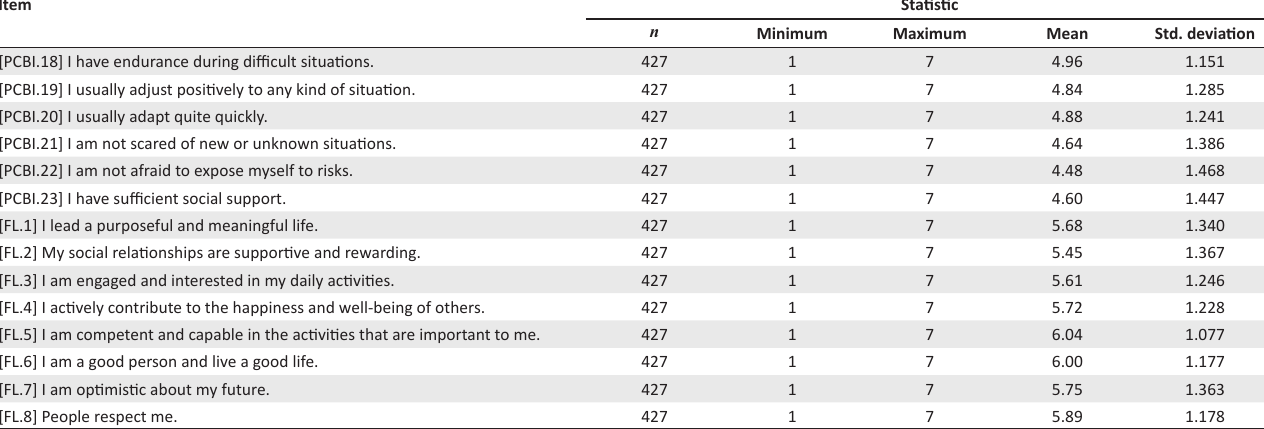
TABLE 1-A1 (Continues...): Descriptive statistics: Means and standard deviation at item level.